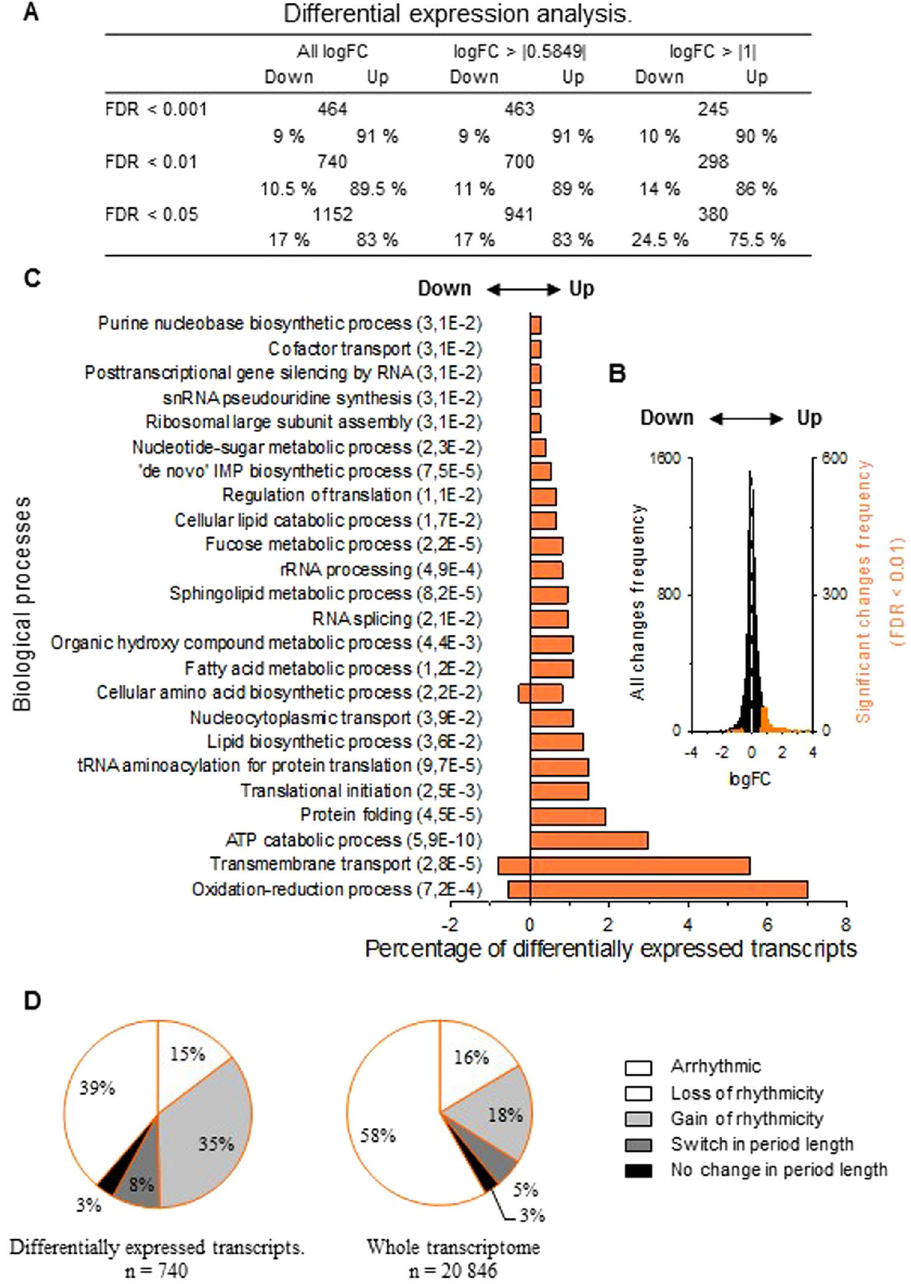
Figure 6. Effect of A. minutum on gene expression level throughout the whole transcriptome. ( A ) Number of differentially expressed (DE) transcripts in A.m for different significances (FDR) and fold changes (log FC). ( B ) Fold change distribution. The black bars represent equally expressed transcripts, while the orange bars represent DE transcripts. The white dotted line shows the limit between up- and downregulated transcripts. ( C ) Enrichment analysis of biological processes of DE transcripts with an FDR of < 0.01. The ordinate axis shows the GO term and significance of enrichment (FDR) while the abscissa axis shows the percentage of DE transcripts enriched for each GO term. Positive and negative values indicate up- and downregulated transcripts, respectively. ( D ) The right pie chart shows the cycling transcripts’ status for the DE transcripts. The left pie chart shows the cycling transcripts’ status for the whole transcriptome in A.m